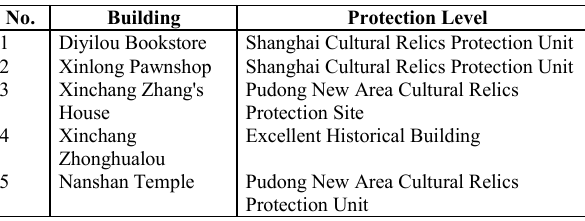
Table 4 . The historical buildings selected as the viewpoints for the viewshed tool. (Part of the complete data, proposed by